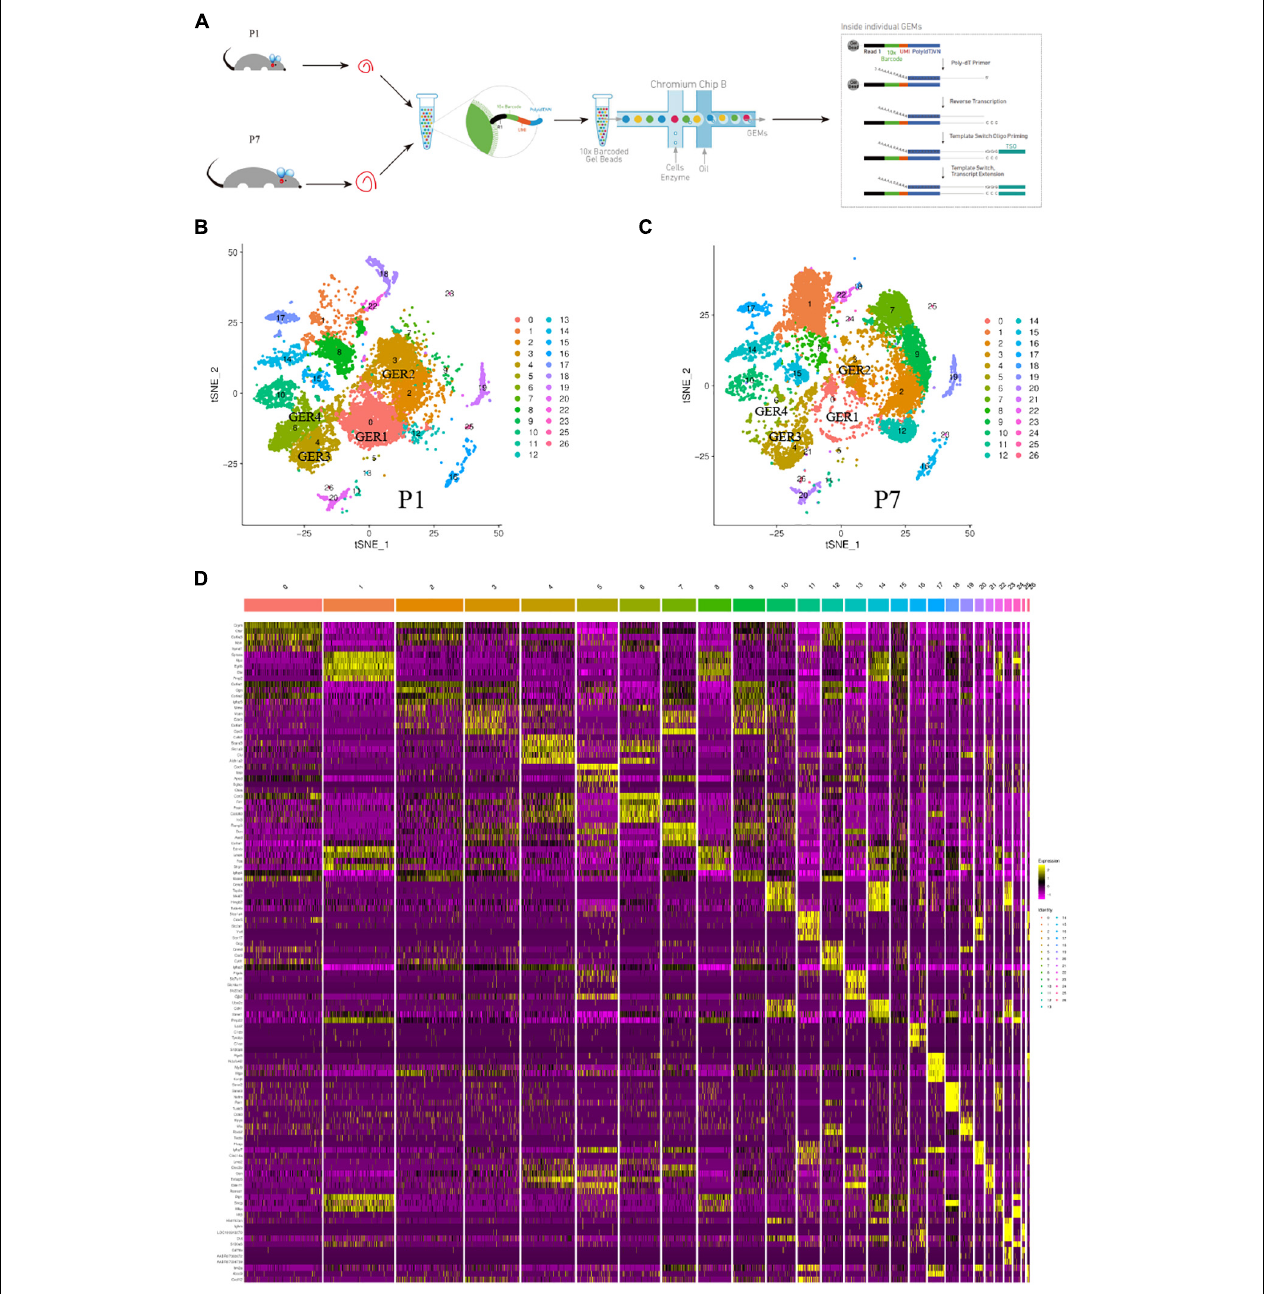
FIGURE 1 | Global expression profiling of cochlear cells by scRNA-Seq and cell clusters identification. (A) Scheme of cochlear duct preparation, single-cell isolation, and Chromium 10x Genomics library and scRNA-seq at P1 and P7. (B) t-SNE plots of cochlear cells at P1. (Left) Cell colors based on the origins (donors) are shown. (C) t-SNE plots of cochlear cells at P7. (Right) Cell colors based on the origins (donors) are shown. (D) Heat map for cochlear cell clusters. The top 5 deferentially expressed (DE) genes for the 26 identified clusters are shown. Cellular identity for each cluster is indicated by a color bar at the top of the heat map. The color ranges from blue to bright yellow indicates low to high gene expression levels,